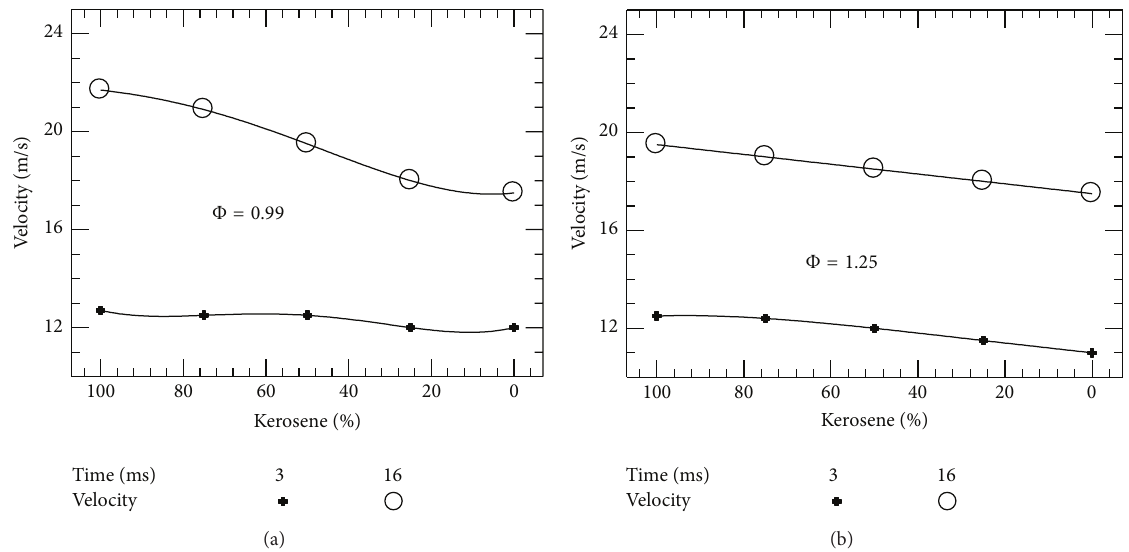
Figure 6: Effect of kerosene content on flow velocity for turbulent premixed kerosene light diesel blends-air flame for different equivalence ratios and residence time with Re = 11.08 × 10 3 and solidity ratio =